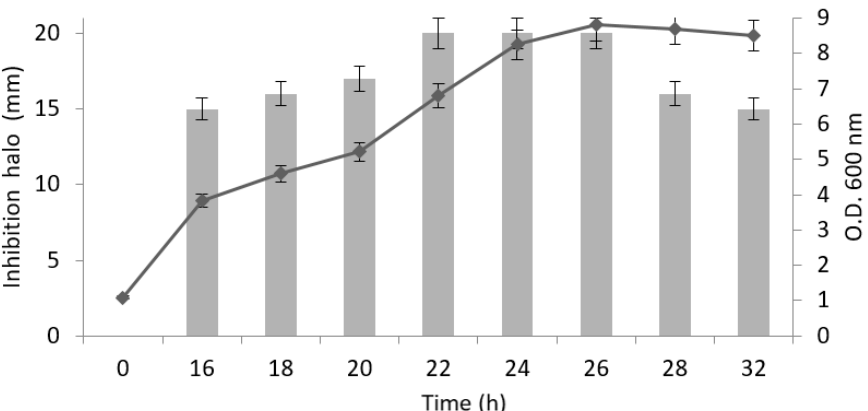
Figure 1. Correlation between W. anomalus strain 18 growth evaluated by measuring optical density O.D. 600 nm (line) and production of mycocin (bars) expressed as the diameter of the halo produced against sensitive strain B. bruxellensis DiSVA 46. Results were obtained from two experiments carried out separately, and relative standard errors were added.